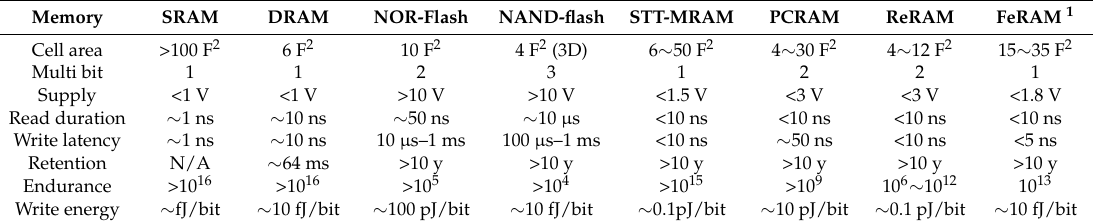
Table 1. Mainstream and emerging memory candidates which drive most of research